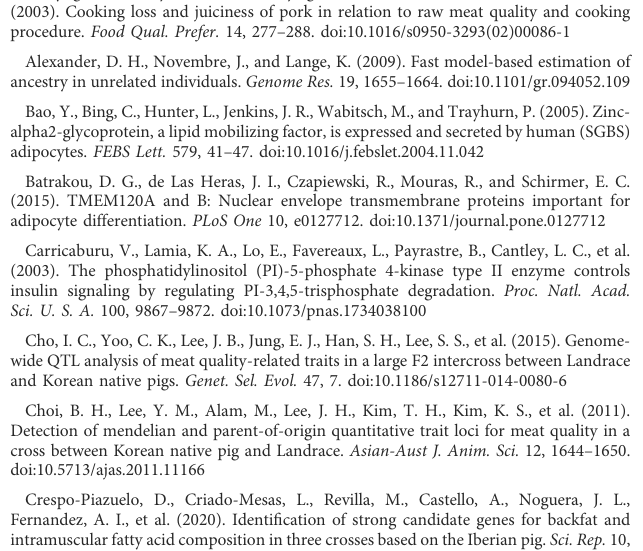
SUPPLEMENTARY FIGURE S3 The density distribution of total SNPs and fi ltered SNPs on Sus